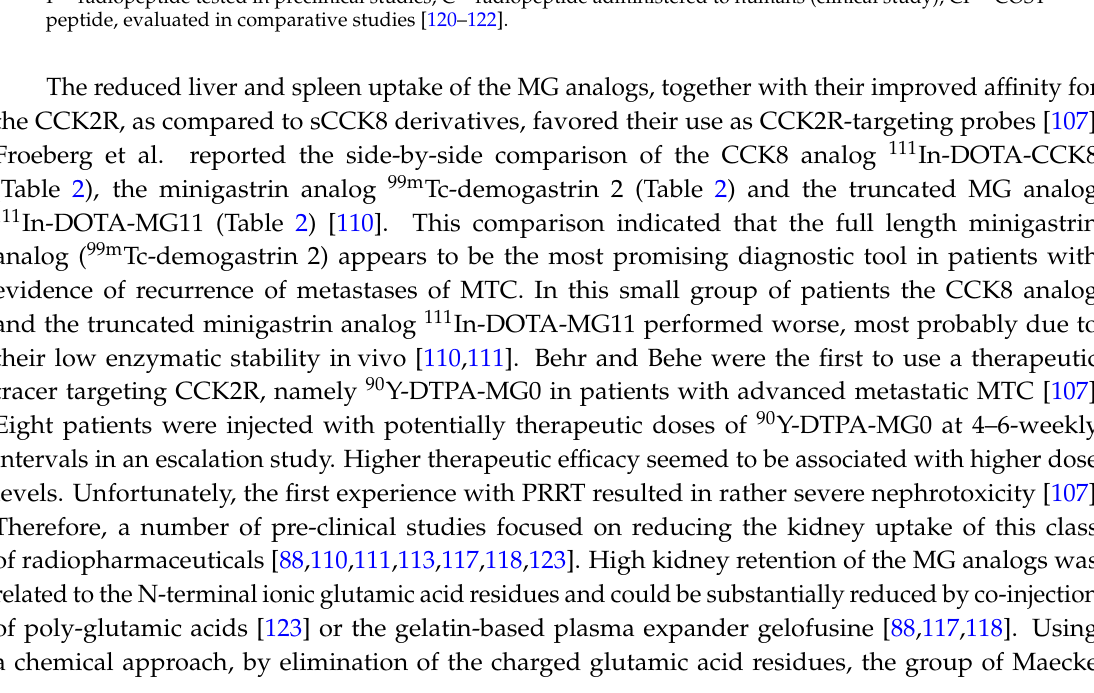
P—radiopeptide tested in preclinical studies; C—radiopeptide administered to humans (clinical study); CP—COST peptide, evaluated in comparative studies [120–122]. The reduced liver and spleen uptake of the MG analogs, together with their improved affinity for the CCK2R, as compared to sCCK8 derivatives, favored their use as CCK2R-targeting probes [107]. Froeberg et al. (Table 2), the minigastrin analog 99m Tc-demogastrin 2 (Table 2) and the truncated MG analog 111 In-DOTA-MG11 (Table 2) [110]. This comparison indicated that the full length minigastrin analog ( 99m Tc-demogastrin 2) appears to be the most promising diagnostic tool in patients